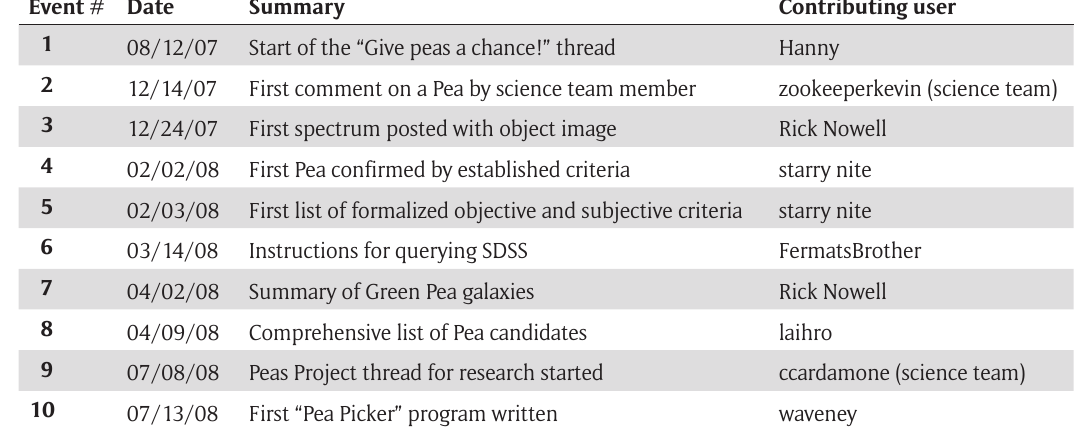
Table 2: Ten events from the GPAC thread. tion and directed users from other threads to post